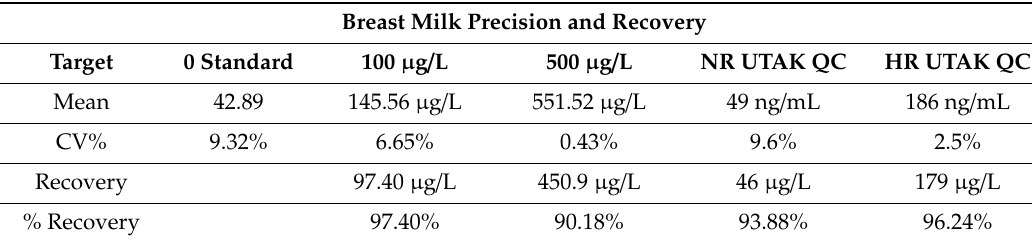
Table 1. Performance characteristics of the iodine